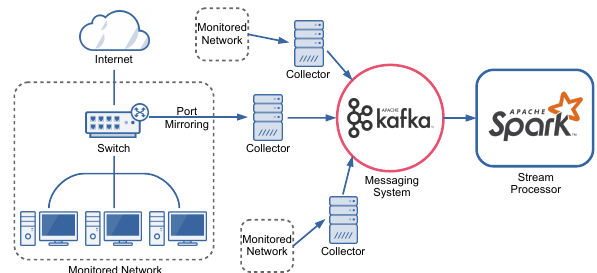
Fig. 1 Architecture of the proposed online monitoring